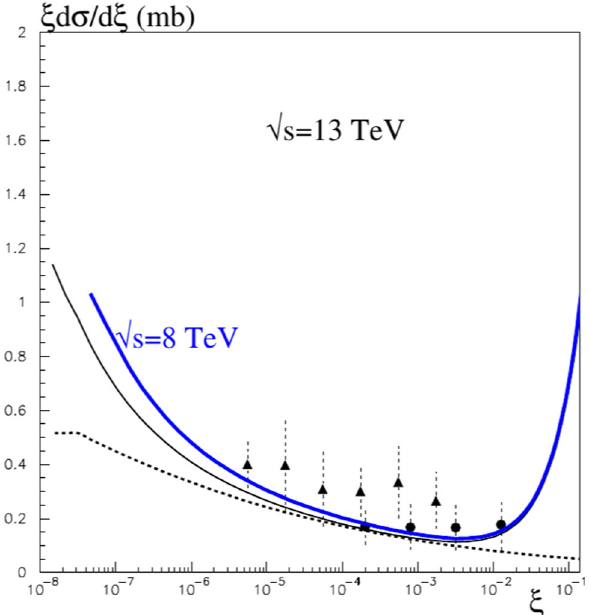
Fig. 7 The ξ dependence of the single dissociation (SD) cross section √ s = 13 TeV (black). The dashed curve is the Pomeron component at Fig. 8 The comparison of the model with the results of the analyses while the continuous curve includes the secondary Reggeon contribu- by Goulianos and Montanha of the CDF data [49] at tion. ATLAS (8 TeV) [50] and CMS (7 TeV) [51] data are shown by t = − 0 . 05 GeV circlesandtrianglesrespectively.TheCMSpointshavebeenreducedby afactorof1.27toapproximatelyaccountforthefactthatthesedatacon- tain some admixture of double dissociation, in addition to pure SD [52]. √ s = 8 TeV. At ξ > 3 · 10 − 5 it Thick blue/upper curve corresponds to is very close to the black curve